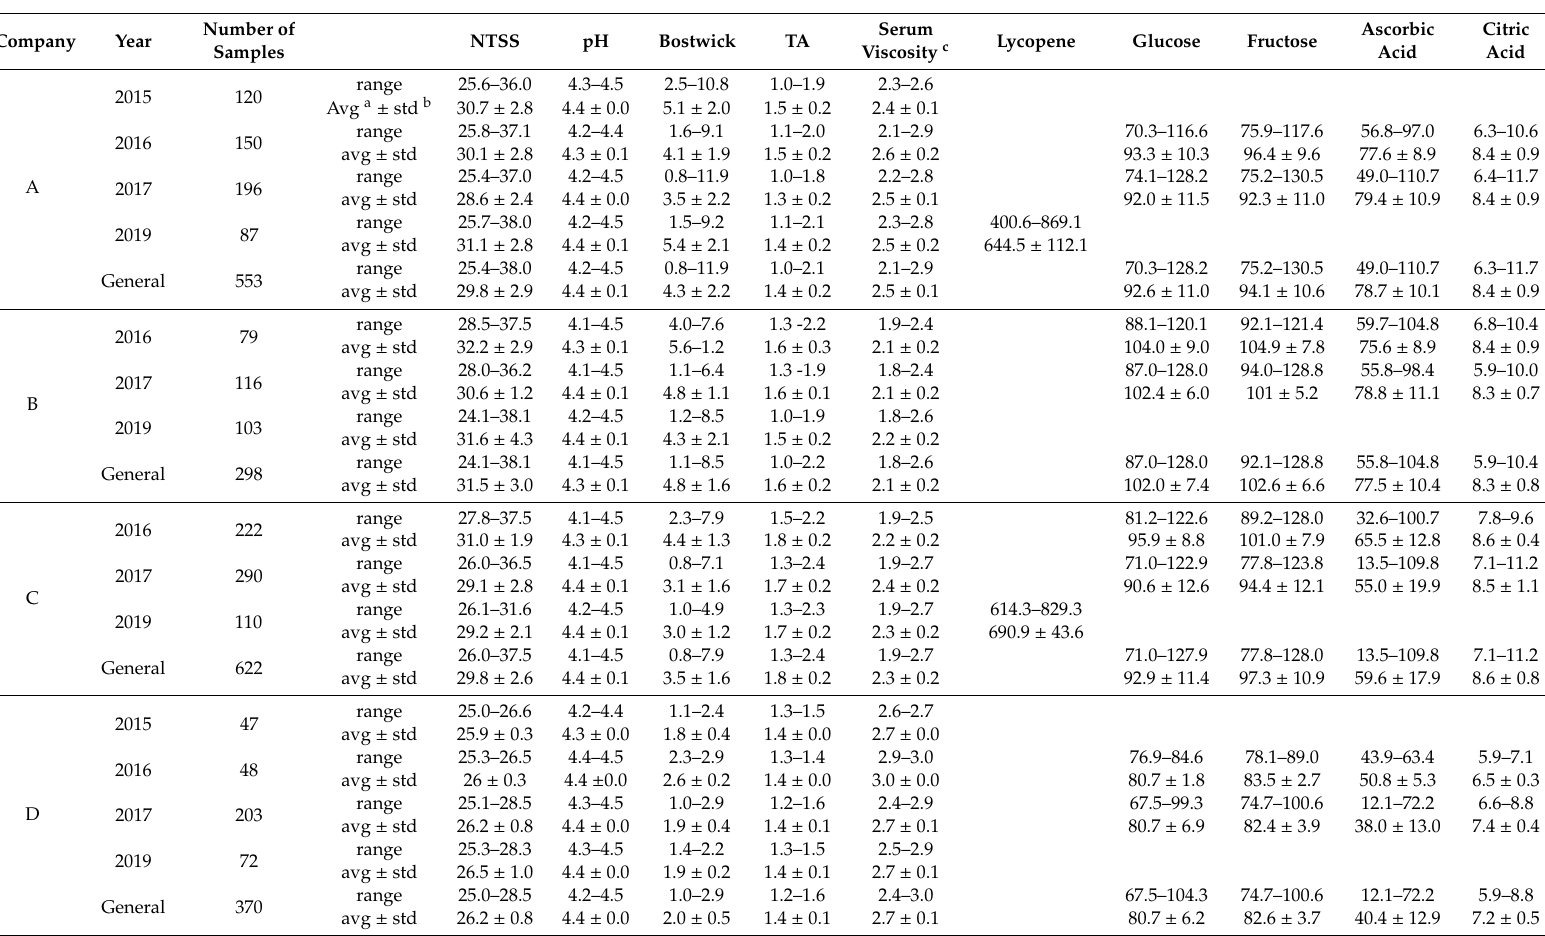
Table 1. Reference method results of quality parameters in tomato paste samples from 4 di ff erent companies at the 2015, 2016, 2017, and 2019 production